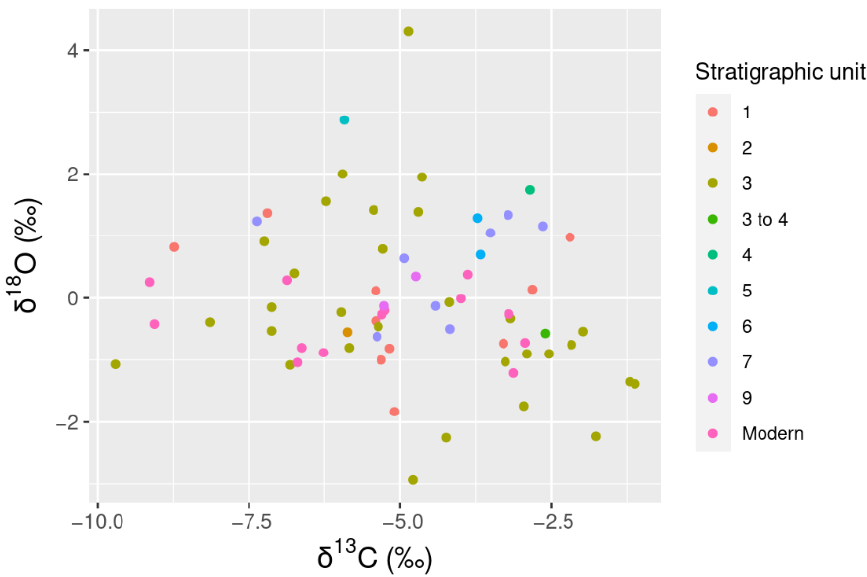
Figure 5. δ 18 O and δ 13 C for L. conspicillatus and O. robustus.